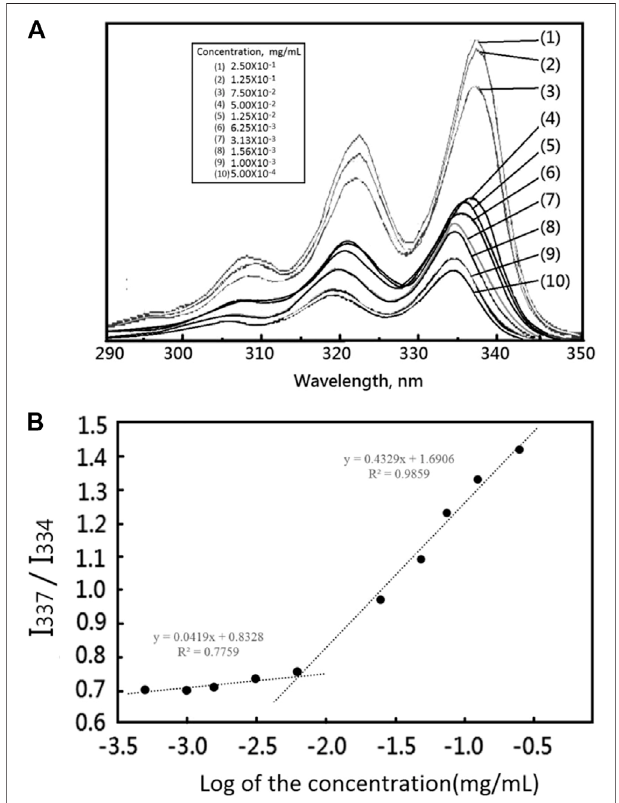
FIGURE 2 | (A) The fl uorescence emission spectra of pyrene as a function of copolymer concentration in distilled water (mg/mL) ([Pyrene] = 6.0 × 10 − 7 M, λ ex = 390 nm). (B) The fl uorescence intensity ratio of I 337 /I 334 from pyreneemissionspectravs.thelogoftheconcentration(logC:mg/mL),a measurement used to determine the CMC for mPEG-Hz- b -PCL.